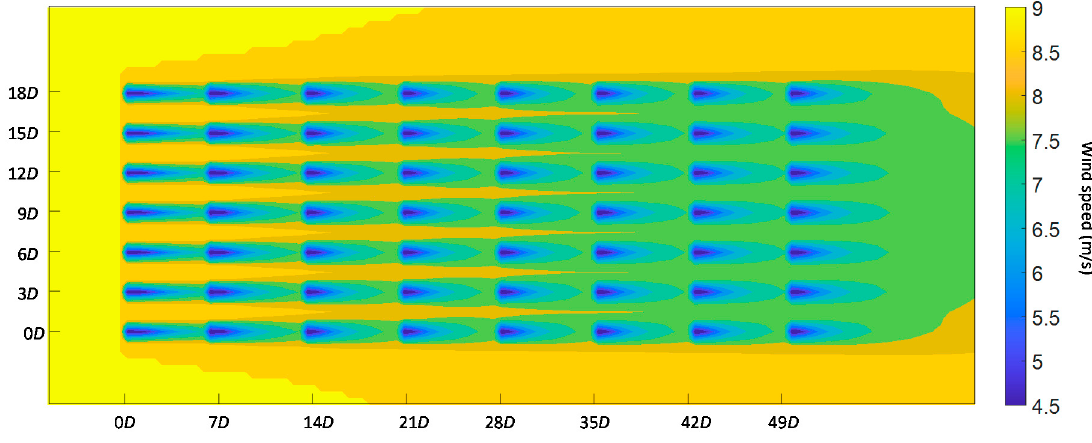
Figure 9. Wind speed field corresponding to the classic operation strategy.